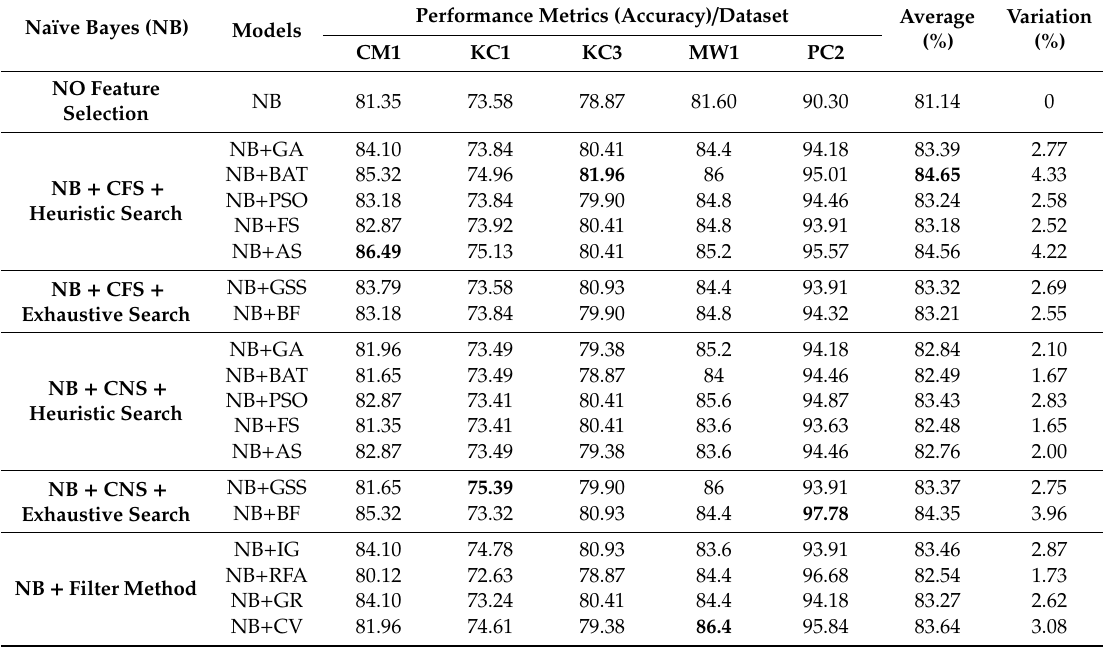
Boldface typeface indicates the highest value for each